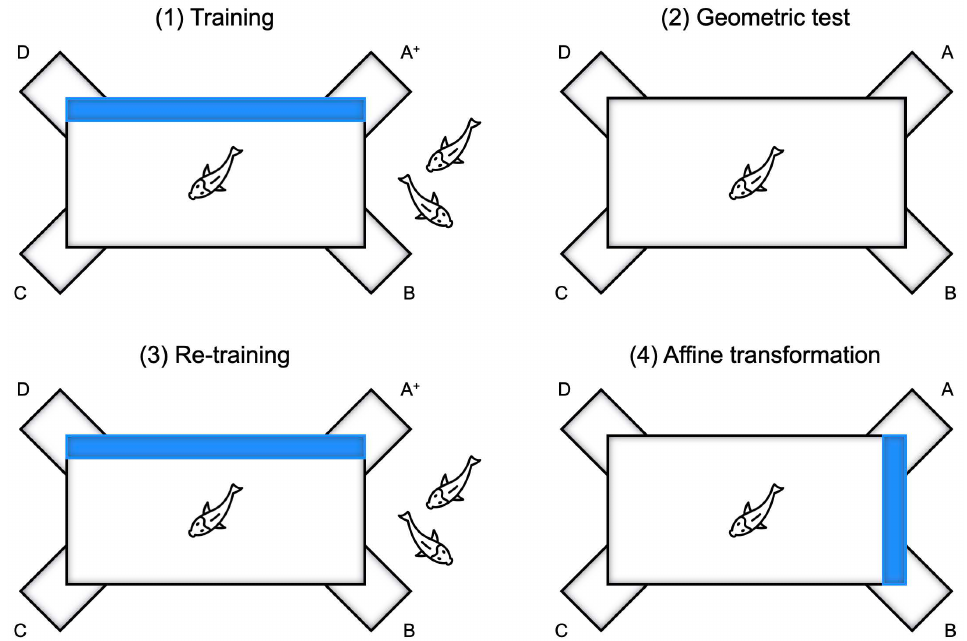
Figure 2. Schematic representation of the four experimental phases (long blue wall version): phase (1) Training; phase (2) Geometric test; phase (3) Re-training; phase (4) Affine